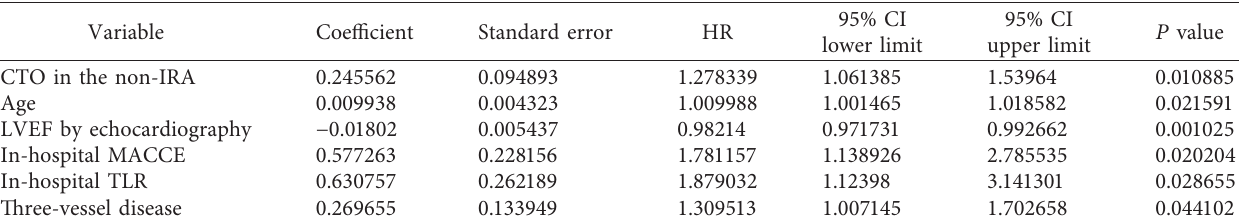
Table 5: Multivariable regression model of MACCE during entire follow-up period in the male study population (only showing CTO in the non-IRA and other variables with statistical